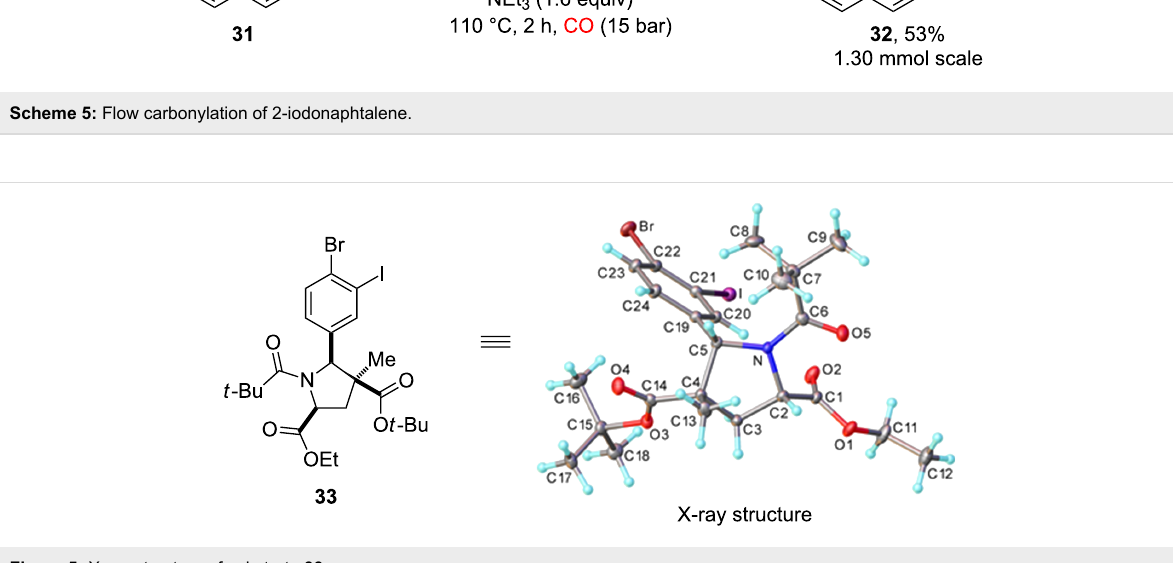
Figure 5: X-ray structure of substrate 33